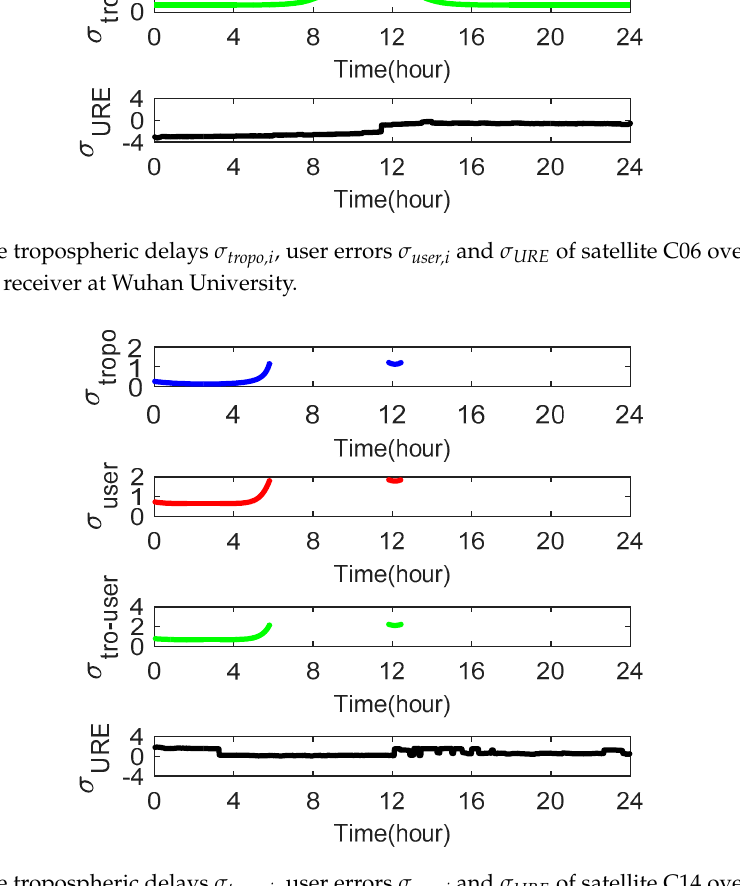
Figure 11. The tropospheric delays σ tropo,i , user errors σ user,i and σ URE of satellite C14 over one day as seen from the receiver at Wuhan University.